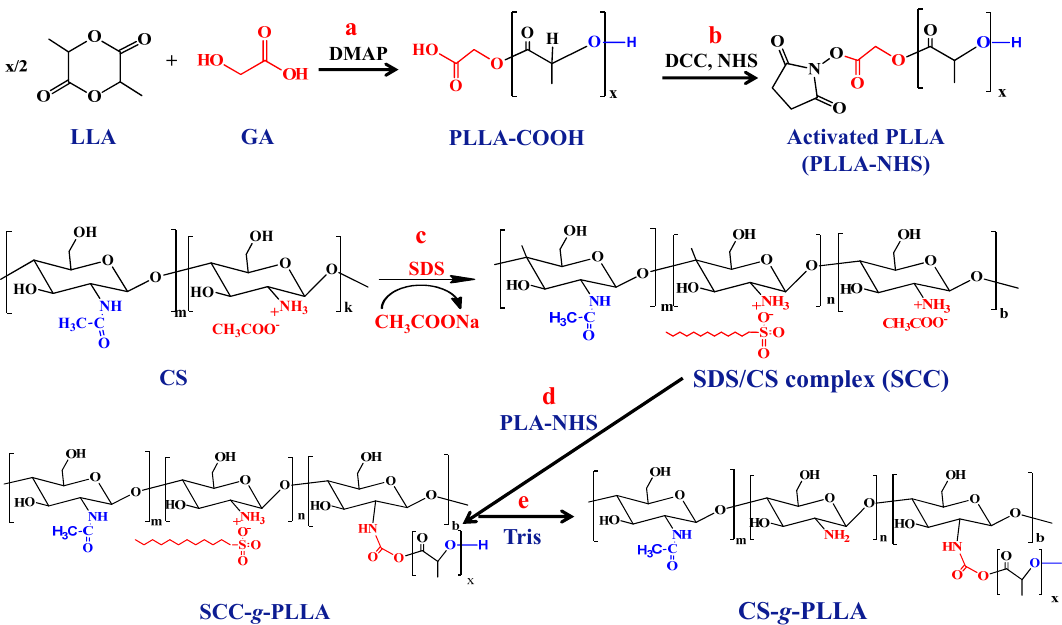
Scheme 1. Schematic representation of the synthetic procedure followed for the preparation of the CS- g -PLLA copolymers: ( a ) ring-opening polymerization of LLA; ( b ) activation of PLLA-COOH; ( c ) formation of the organo-soluble SCC complex; ( d ) grafting of PLLA-NHS onto the SCC backbone; ( e ) elimination of SDS.